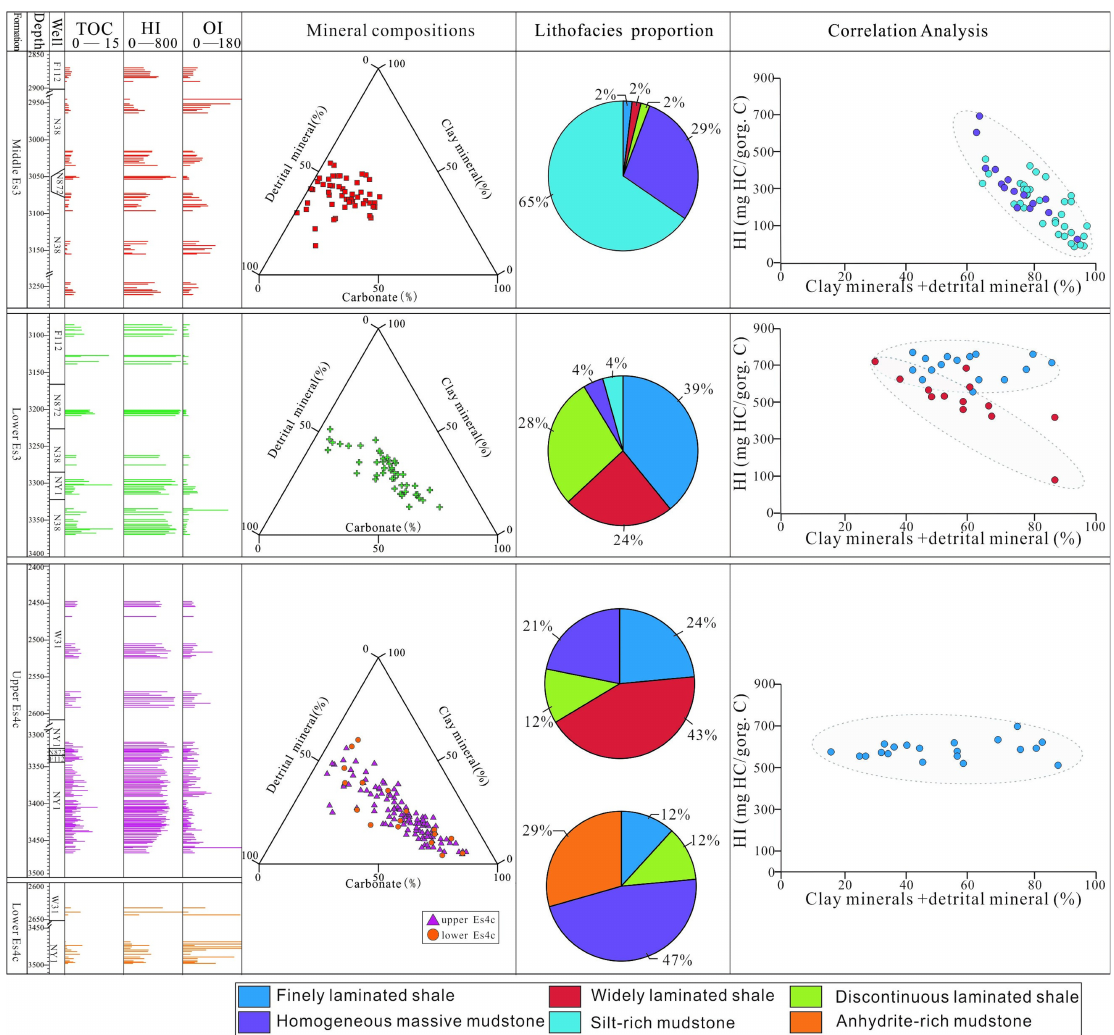
Figure 9. Composite histogram of the middle Es3-lower Es4c sub-members in the Dongying